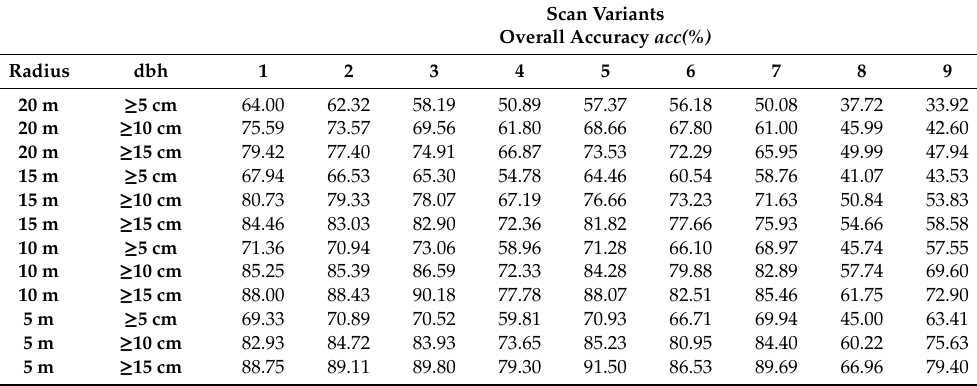
Table A5. Overall accuracies for di ff erent scan variants, lower dbh thresholds, and plot